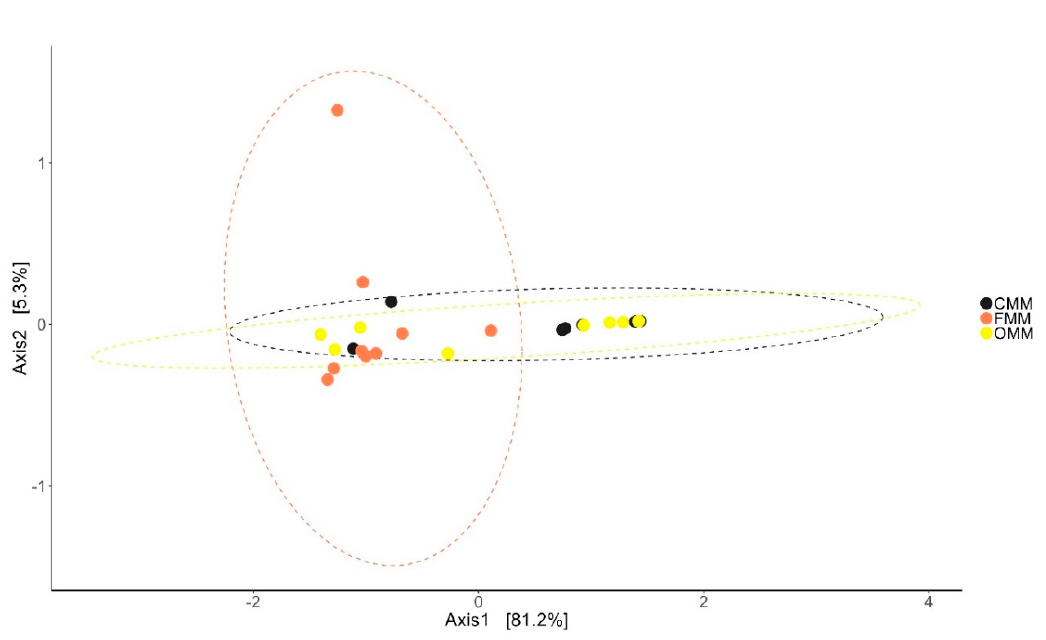
Figure 1. Differences in the beta diversity of the bacterial communities present in the distal intestine mucus of Atlantic salmon. The data in the ellipse-enclosed areas come from a multivariate normal distribution. The codes for the mucus samples are as follows: control group, CDM; florfenicol-fed group, FDM; oxolinic-acid-fed group, ODM.